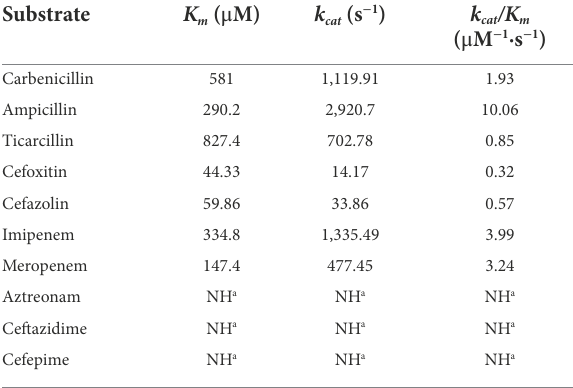
TABLE 4 Kinetic parameters of β -lactam antibiotics for the β -lactamase